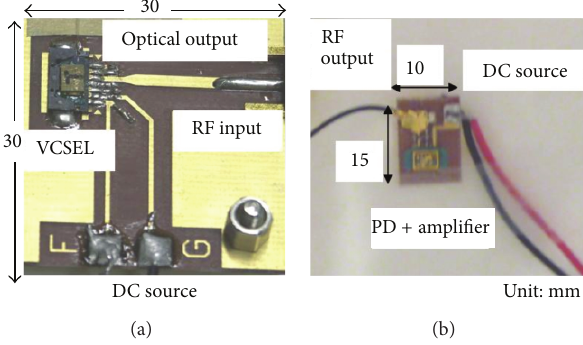
Figure 2: Details of E/O and O/E converters.